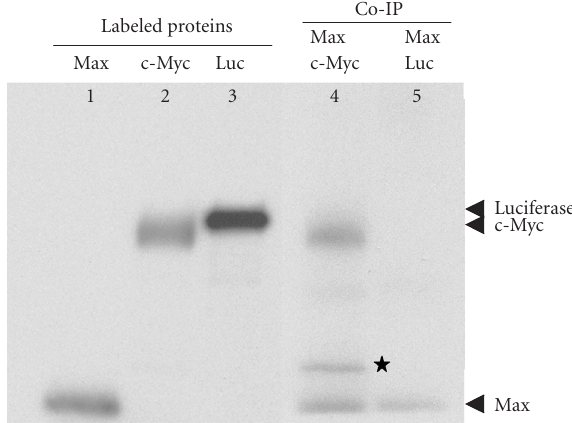
Figure 2. Coimmunoprecipitation of T7-tagged Max and c-Myc using anti-T7 tag antibody cross-linked protein G agarose. Max (T7-tagged), c-Myc, and luciferase were in vitro translated and 35 S-labeled (lanes 1, 2, and 3) using the TNT-Coupled Retic- ulocyte Lysate System. Before co-IP, Max and c-Myc, and Max and luciferase were mixed proportionally and incubated at 30 ◦ C for 1 hour. Co-IPs were carried out with anti-T7 tag antibody cross-linked protein G agarose at 4 ◦ C for 2 hours (lanes 4 and 5) and the eluted protein complexes were separated on 4–20% SDS-PAGE. The 35 S-labeled proteins were detected by autora- diography. Star ( ∗ ): degradation product of